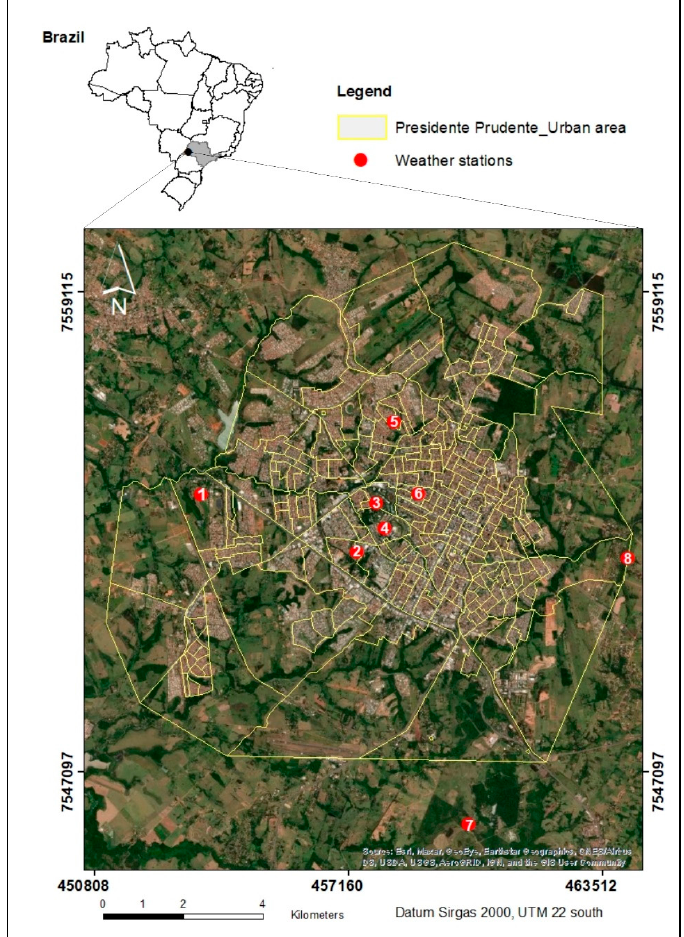
Figure 1. Location of Presidente Prudente, Brazil; measured air temperature points. Source: World Imagery, Esri (2022) [31]. Access: January 2022; IBGE Census Bureau (2010) [32].